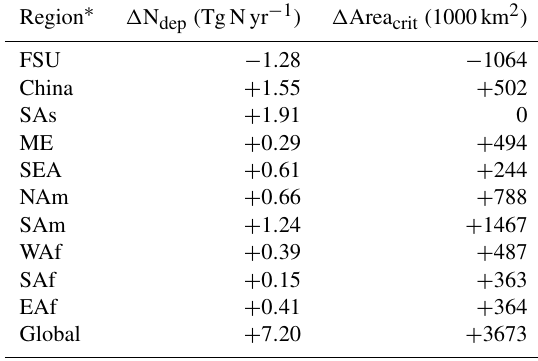
∗ The definitions and abbreviations of all regions can be found in Table